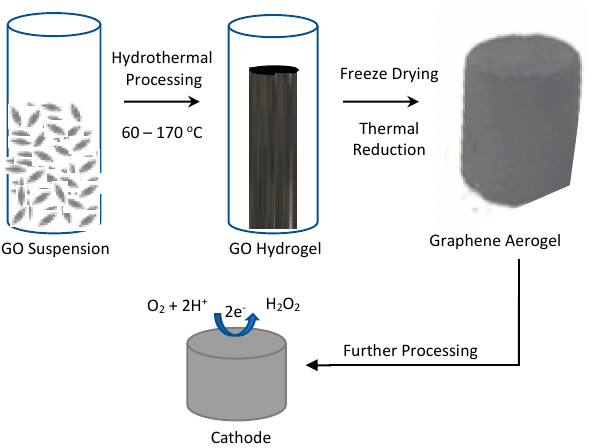
Figure 3. Schematic illustrating the formation of a graphene-based aerogel.